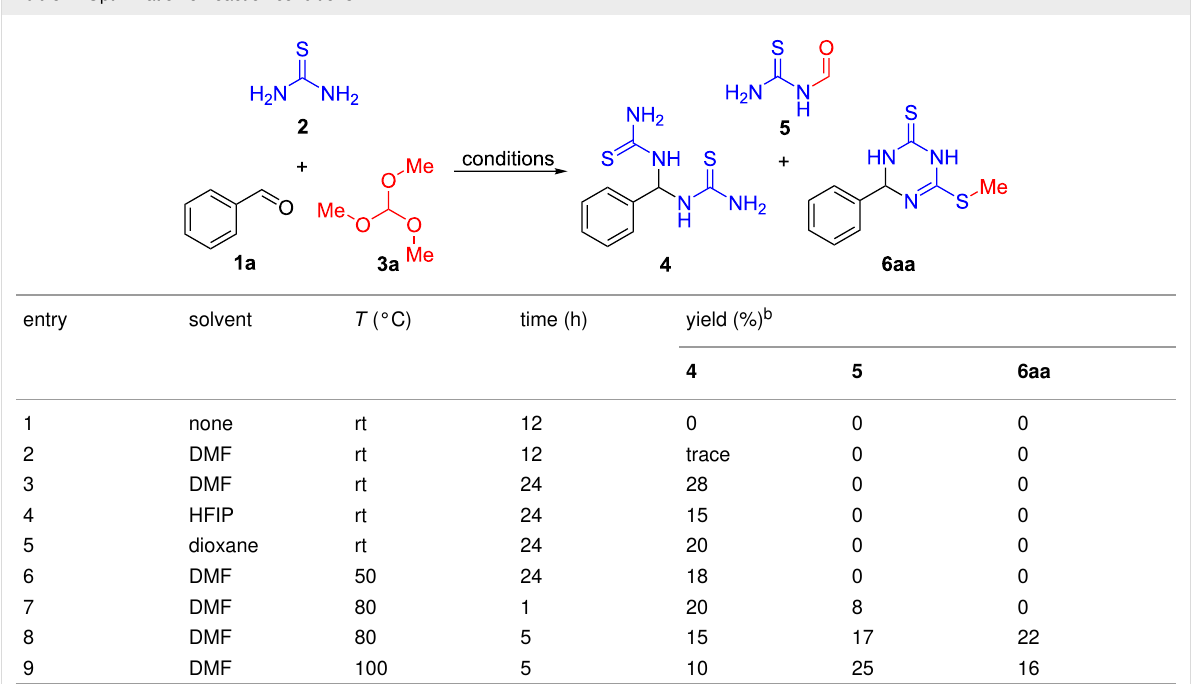
Table 1: Optimization of reaction conditions.